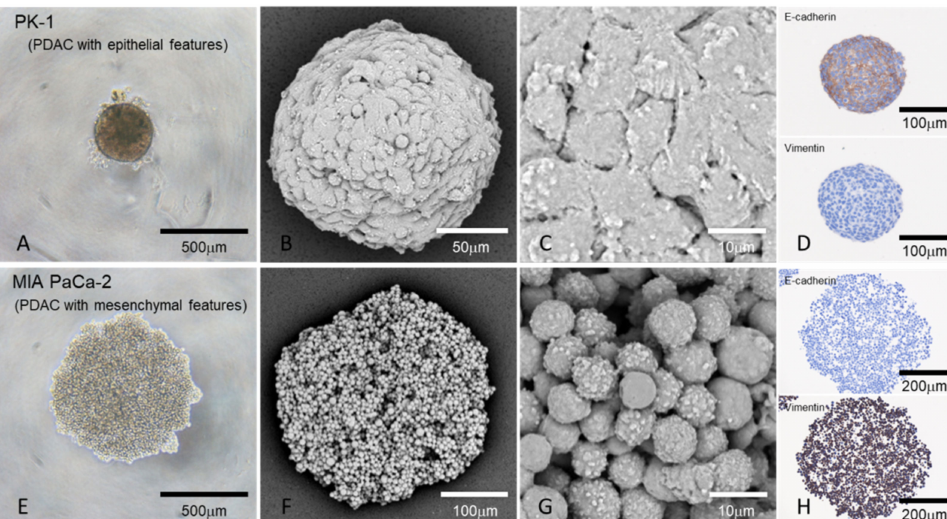
Figure 3. Morphology and epithelial or mesenchymal features of PDAC cell lines grown in 3D culture. PK-1 cells that have epithelial features formed small, firm spheres with slightly larger cancer cells that adhered to each other at the surface of the spheres ( A – C ) [16,37]. In contrast, MIA PaCa-2 cells with mesenchymal features formed large and loose spheres without fusion of the cancer cells ( E – G ) [16]. The PK-1 spheres were strongly positive for E-cadherin and negative for vimentin by immunostaining ( D ), while MIA PaCa-2 showed the opposite staining pattern for these markers ( H ). PK-1 and MIA PaCa-2 cells were cultured in low attachment plates with 10% fetal bovine serum containing RPMI1640 medium for 7 days. Left panels ( A , E ): phase-contrast images; middle panels ( B , C , F , G ): scanning electron microscopy with reflected electrons; right panels ( D , H ): immunocytochemical analyses using cell blocks of spheres. (Supplementary Materials and